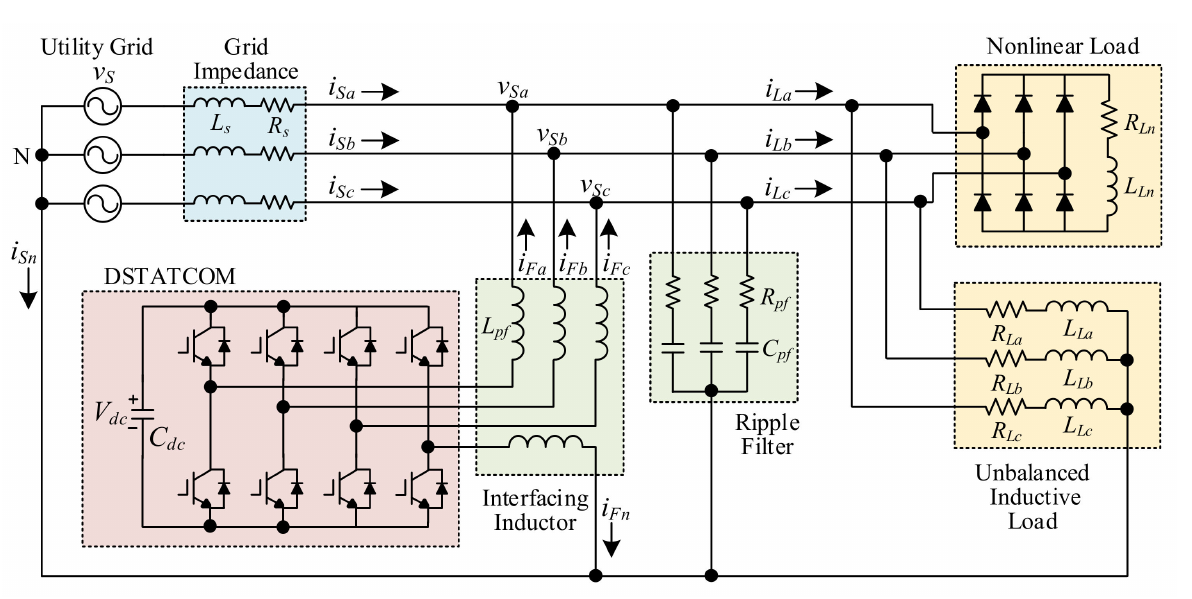
Figure 1. Schematic diagram of three-phase four-wire VSC-based DSTATCOM with nonlinear and unbalanced inductive